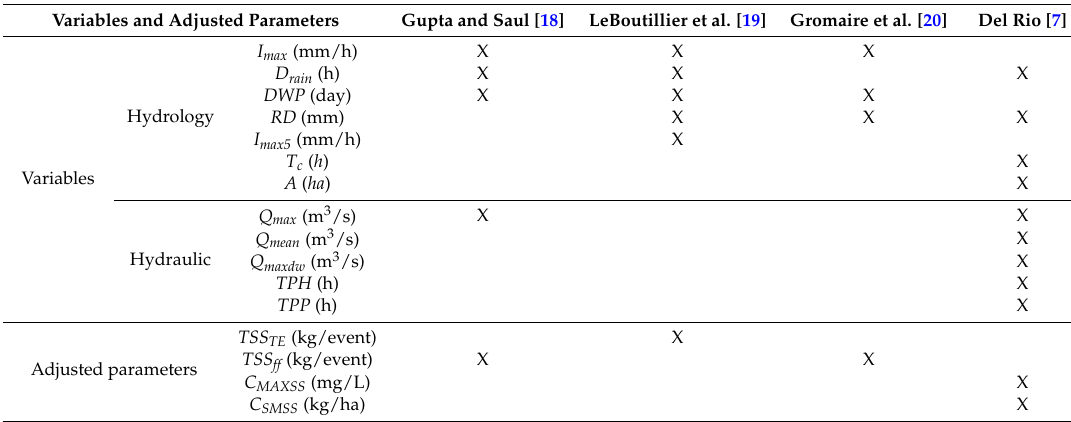
Table 1. Variables and adjusted parameters of TSS pollution